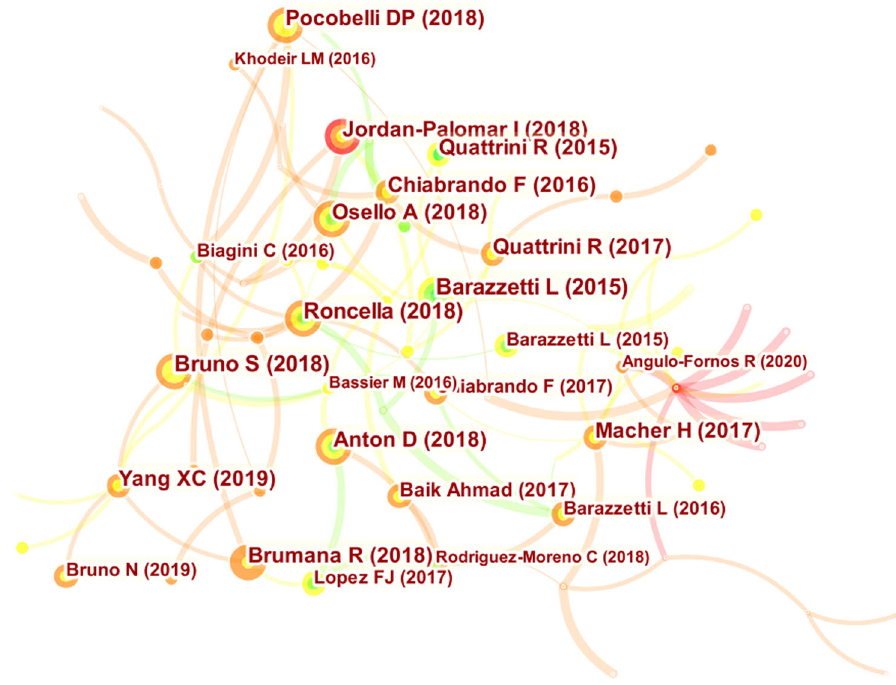
Fig. 7 Co-citation analysis of literature. Co-citation analysis of literature analyzed by CiteSpace bibliometric analysis